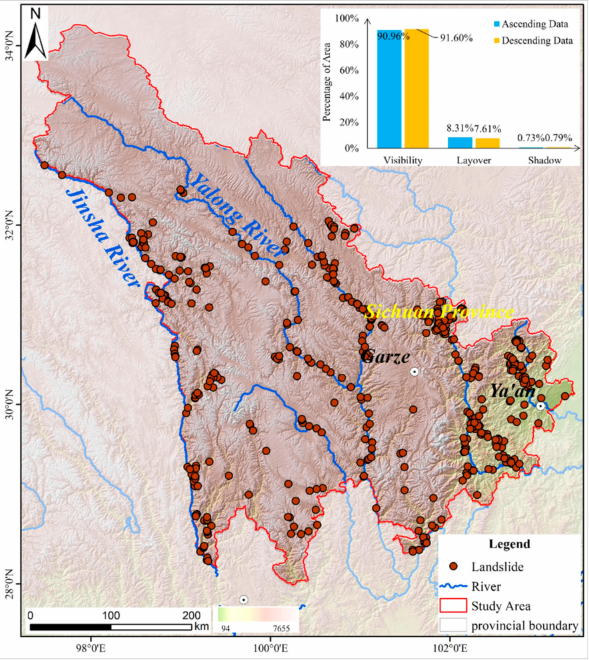
Figure 9. The overall distribution map of potential landslides identified in the study area. The upper-right corner is the statistics of the percentage of Sentinel-1 data visibility distribution area in the study